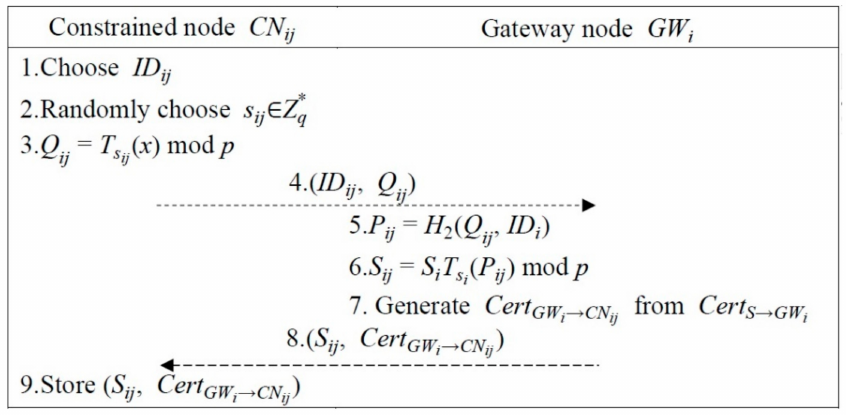
Figure 4. Constrained node registration phase of proposed